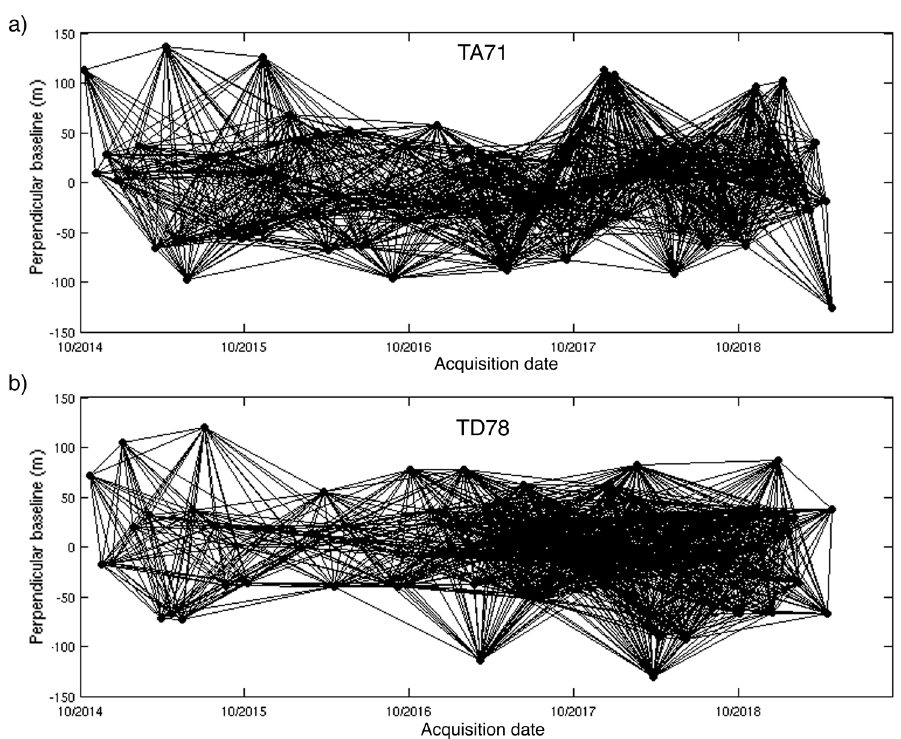
Figure 3. Spatial and temporal baselines of interferograms in ( a ) ascending TA71 and ( b ) descending TD78 tracks.